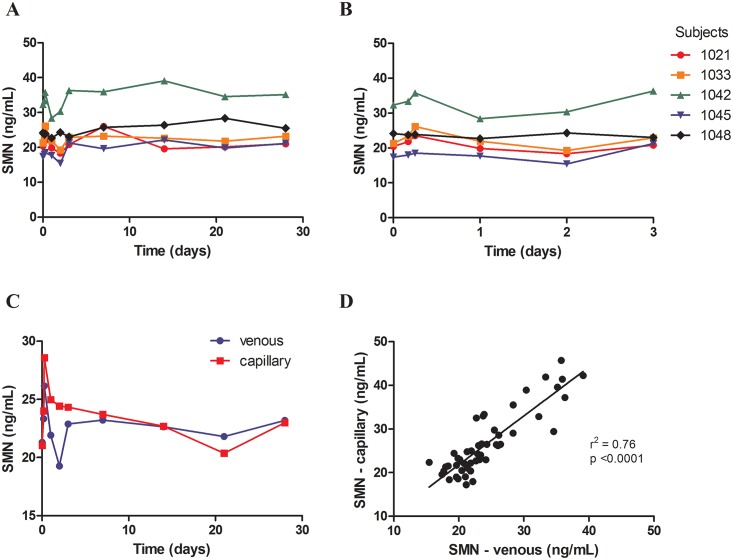
SMN protein levels in capillary and venous blood obtained over time from healthy volunteers did not vary significantly.Venous (A, B) and capillary (C) whole blood samples were obtained at 0, 4, 6, 24, 48, 72 hours and 1, 2, 3, 4 weeks from five healthy individuals. Fig 2B is an expanded version of Fig 2A. (D) SMN protein levels in capillary blood correlated significantly with SMN levels in venous blood (r2 = 0.76, p < 0.0001).